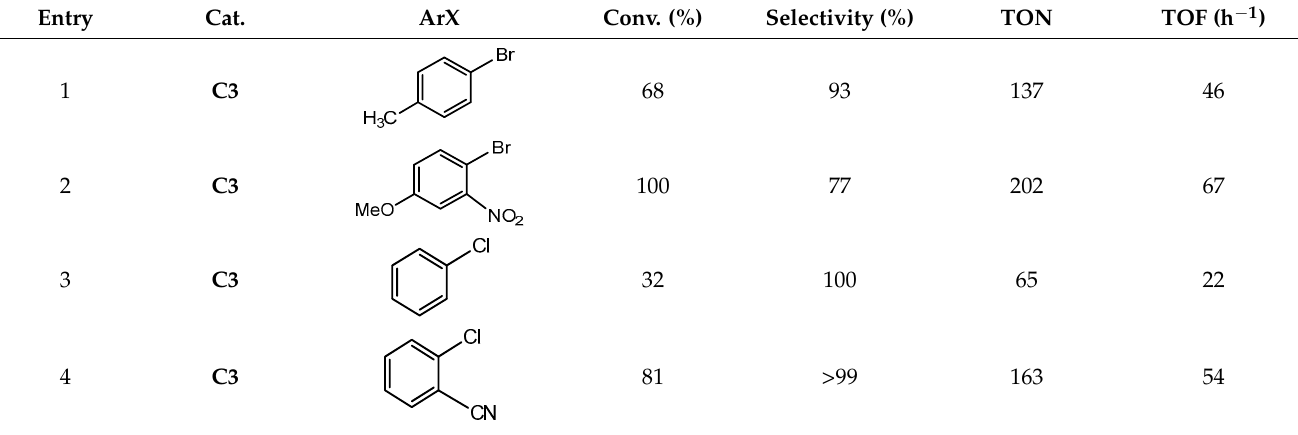
32% conversions (Table 13, entry 1). Table 13. Results obtained from Suzuki ‐ Miyaura cross ‐ coupling of activated and deactivated aryl halides with phenyl ‐ Table 13. Results obtained from Suzuki ‐ Miyaura cross ‐ coupling of activated and deactivated aryl halides with phenyl ‐ Table 13. Results obtained from Suzuki ‐ Miyaura cross ‐ coupling of activated and deactivated aryl halides with phenyl ‐ Table 13. Results obtained from Suzuki ‐ Miyaura cross ‐ coupling of activated and deactivated aryl halides with phenyl ‐ Table 13. Results obtained from Suzuki-Miyaura cross-coupling of activated and deactivated aryl halides with phenylboronic acid. boronic acid. boronic acid. boronic acid. boronic acid. Entry Cat. ArX Conv. (%) Entry Cat. ArX Conv. (%) Entry Cat. ArX Conv. (%) Entry Cat. ArX Conv. (%)